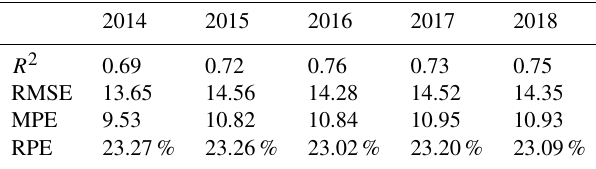
Table 1. The R 2 values, RMSE, MPE, and RPE of RF–GAM in different years during 2014–2018 over the Tibetan Plateau.